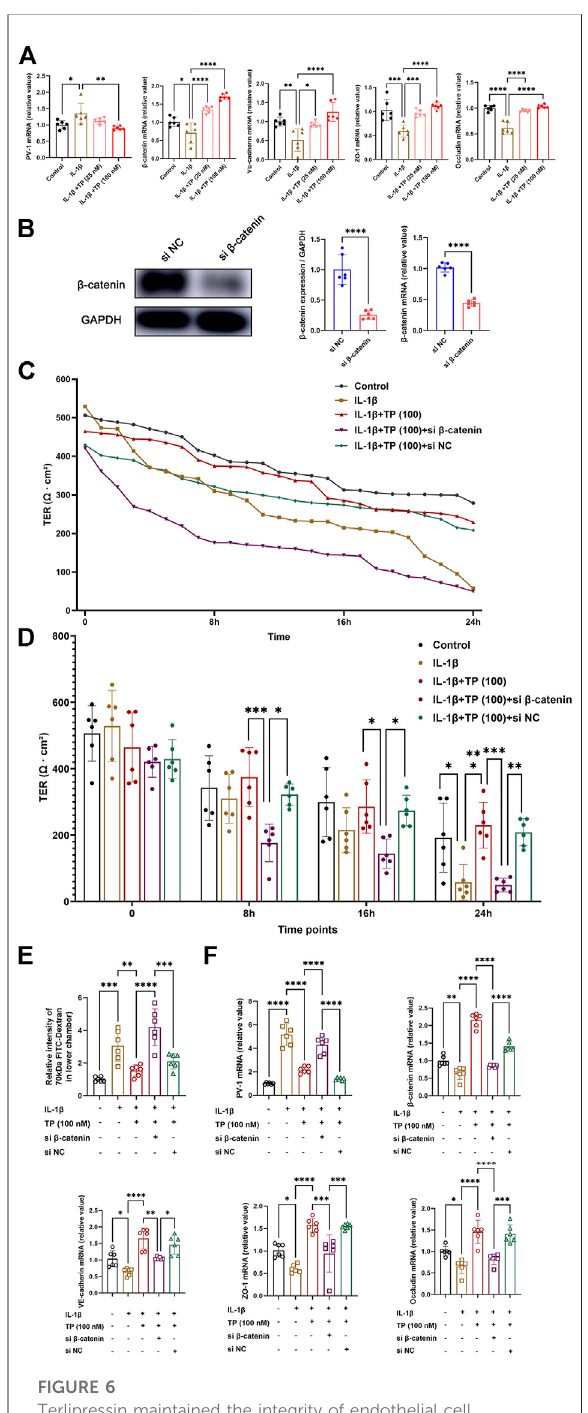
FIGURE 6 Terlipressin maintained the integrity of endothelial cell monolayerduringIL-1 β stimulation via β -catenin.Adherenthuman umbilical vein endothelial cells (HUVECs) were cultured in six-well plates and incubated with or without 10 ng/ml recombinant human interleukin-1 β for 24 h (A) PV-1, β -catenin, VE-cadherin, ZO-1 and occludin mRNA expression with IL-1 β and different dosesofterlipressin(25 nMor100 nM)treatmentinHUVECs.After transfection with small interfering RNA for 24 h (si β -catenin or si Negative control), (B) cell lysates were immunoblotted with β - catenin to verify the ef fi ciency and quantitative analysis, and (C,D) ( Continued